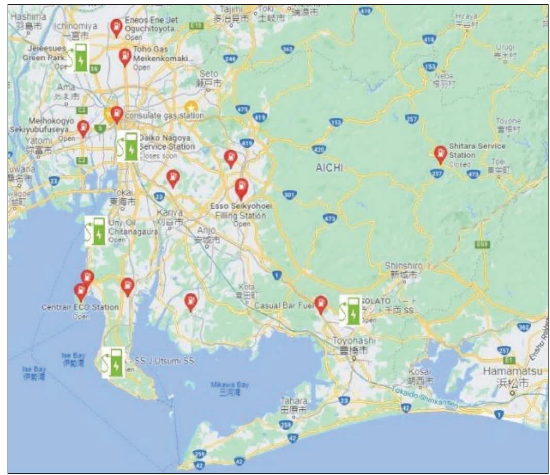
Figure 9: EVCS locations (Model M